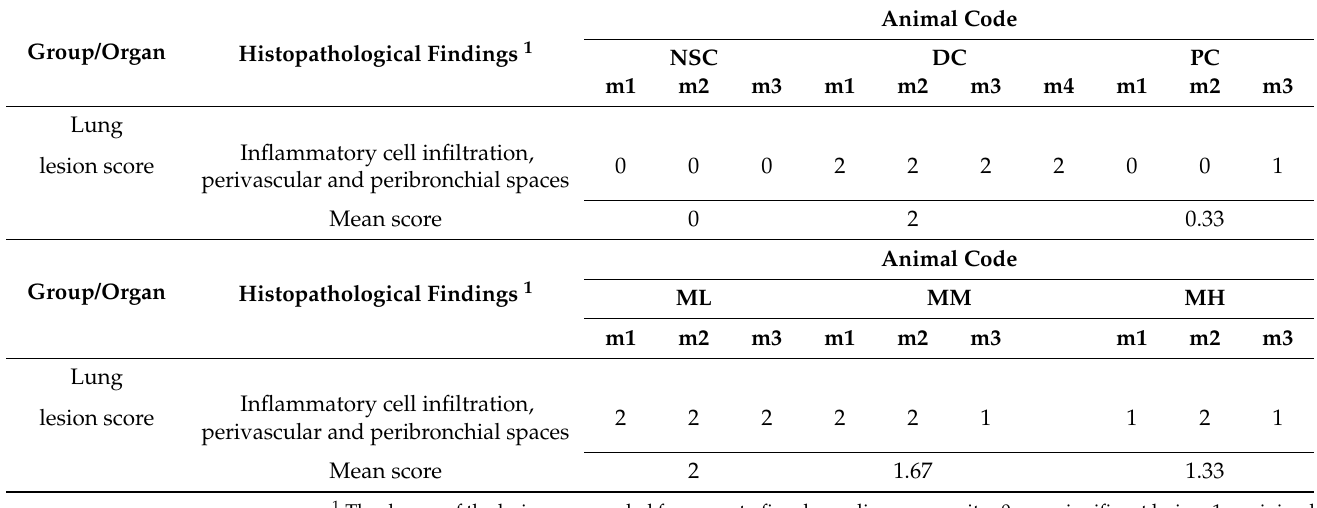
Table 4. Pathology—individual score of the lungs in the OVA-induced peribronchiolitis mice.